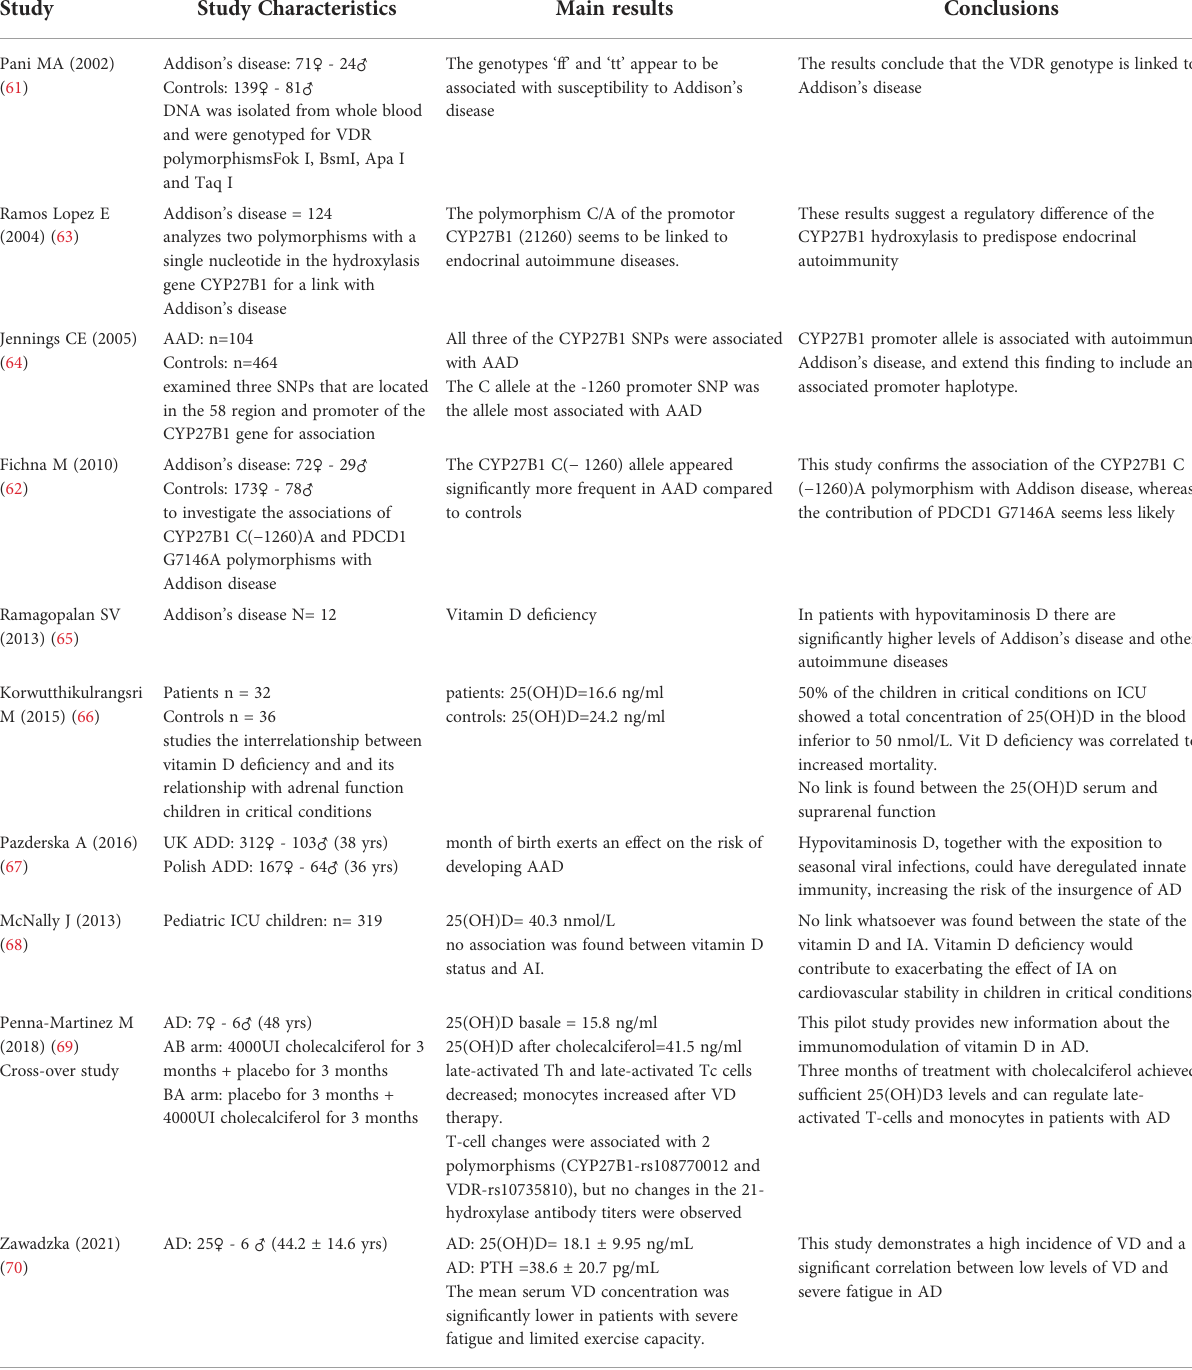
TABLE 4 Main characteristics of the 10 studies included in the review on Primary Adrenal Insuf fi ciency and Vitamin